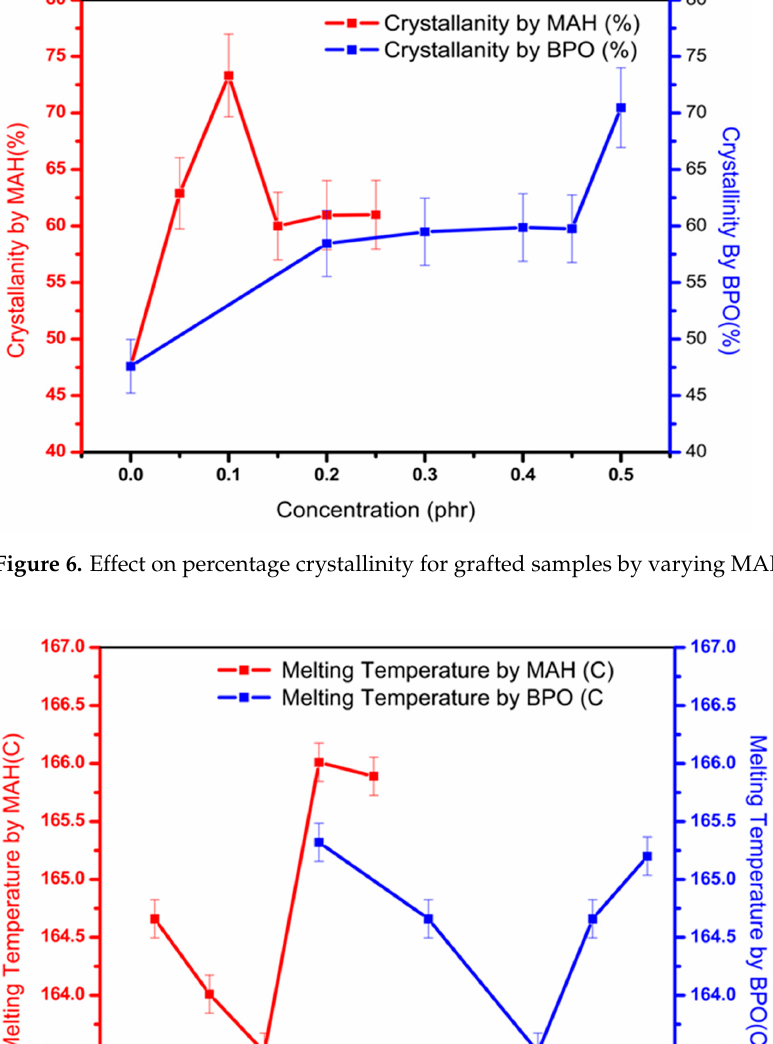
Figure 6. Effect on percentage crystallinity for grafted samples by varying MAH and BPO content.